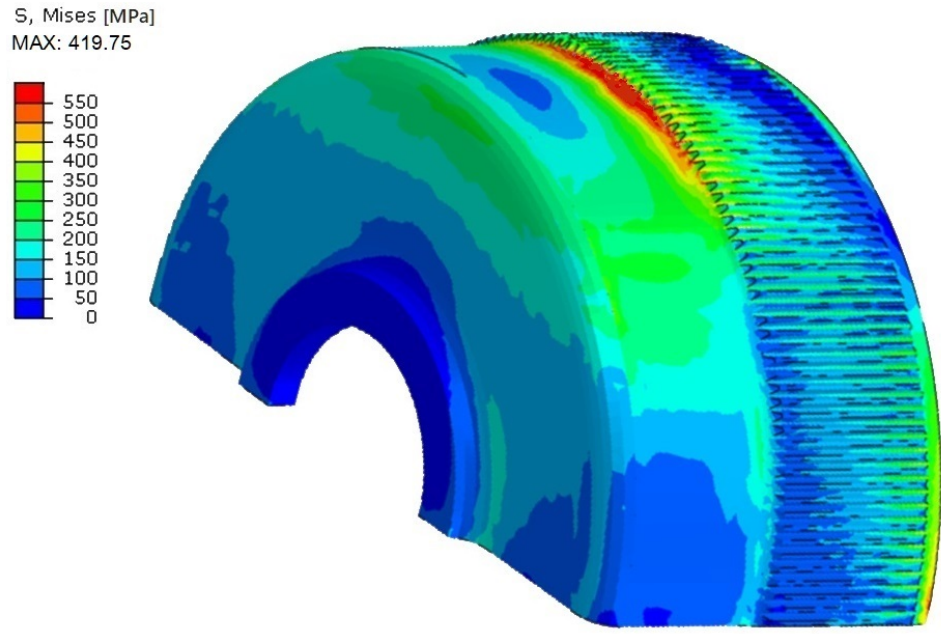
Figure 6. The distribution of the stresses in the flexspline model—variant II.